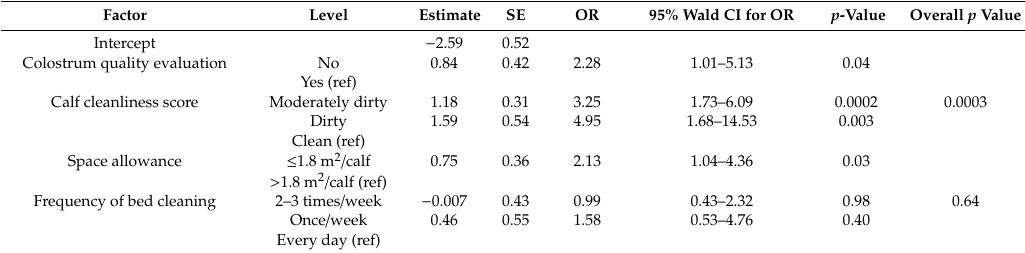
Table 5. Final multilevel regression model for respiratory disease in 700 calves raised in group pens on 29 farms in Los R í os region,